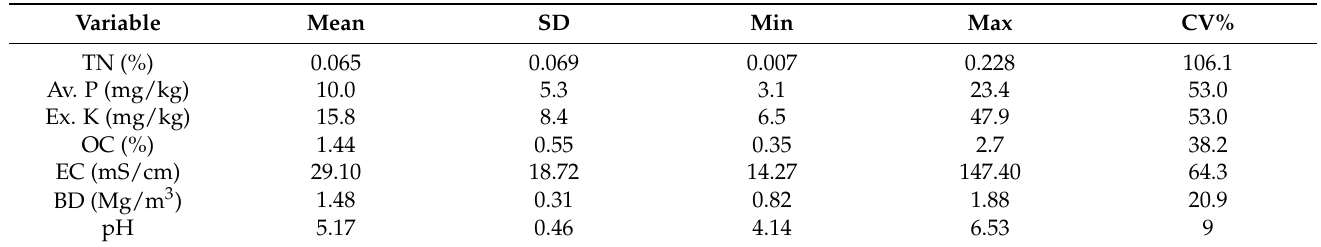
Table 2. Summary statistics of the measured soil chemical and physical parameters of 67 soil samples collected in a single time point from the Endane Biodiversity Corridor, linking the Iharakanda Proposed Forest Reserve and Sinharaja Rainforest Complex in the Rathnapura District of Sri